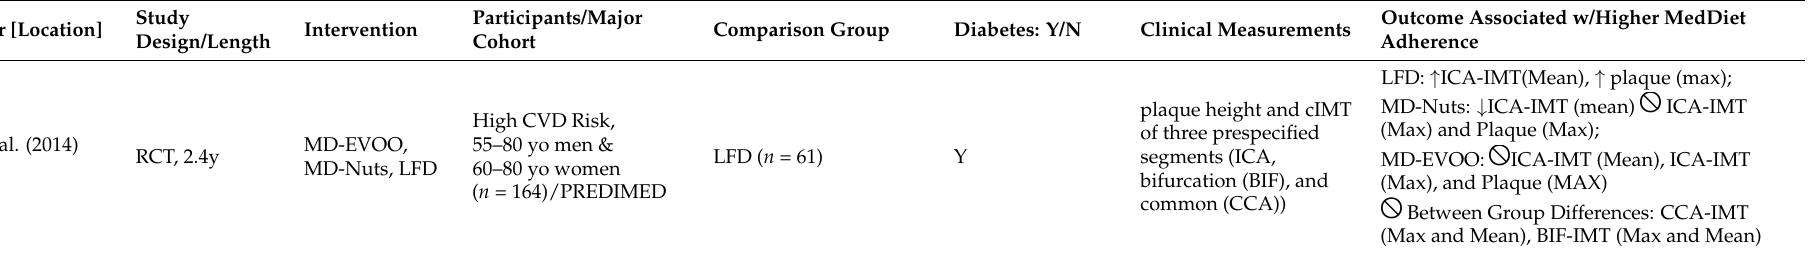
Table 2. Clinical